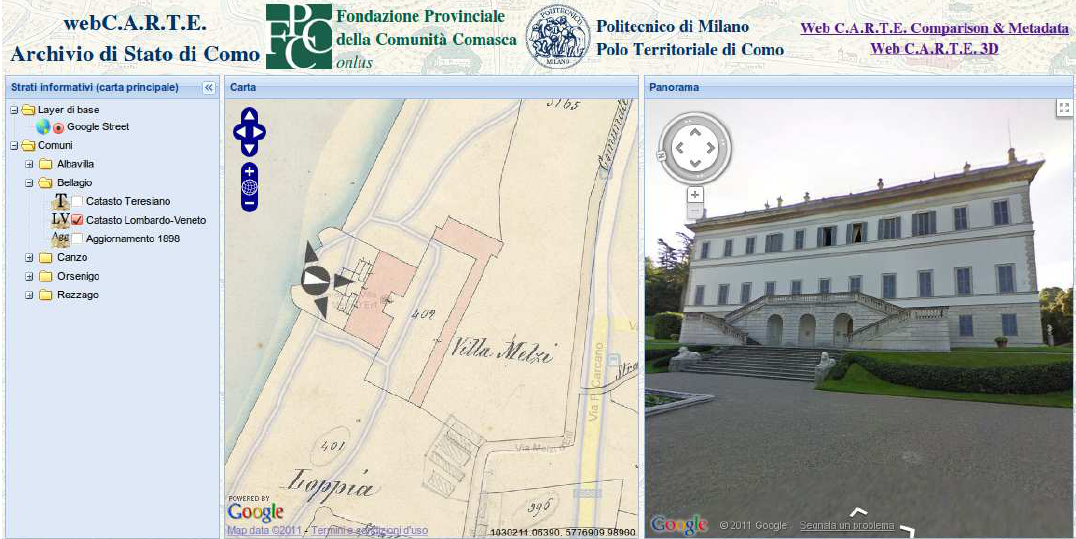
Figure 3. Example of integration between a Lombardo-Veneto cadastral map and the current Google Street View